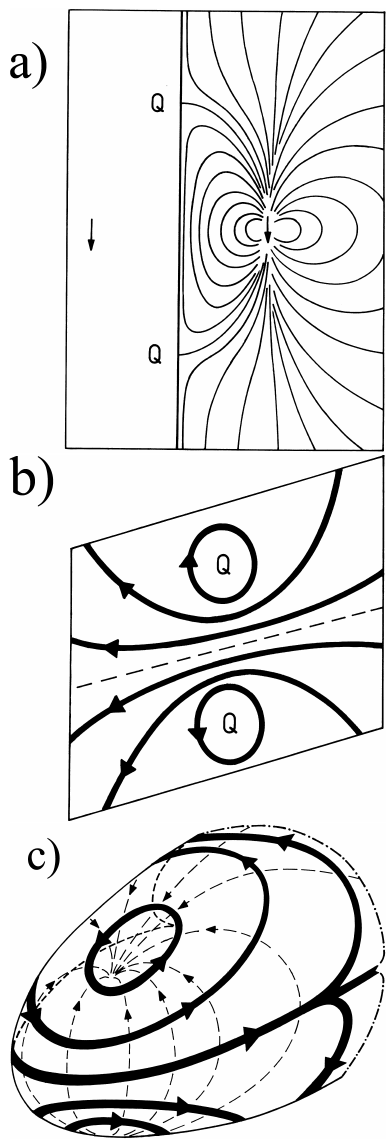
Fig. 1. Simple illustrative model for the magnetosphere, obtained by considering the solar wind as an ideally conducting wall (Chap- man and Bartels, 1940; Alfv´en, 1950). (a) shows the magnetic field lines, and (b) selected surface current paths at the interface, being representative for a continuous distribution. The magnetic field van- ishes at the cusp-points labeled Q . A schematic illustration of the deformation of the surface of current-paths in (b) is shown in (c) for a more realistic